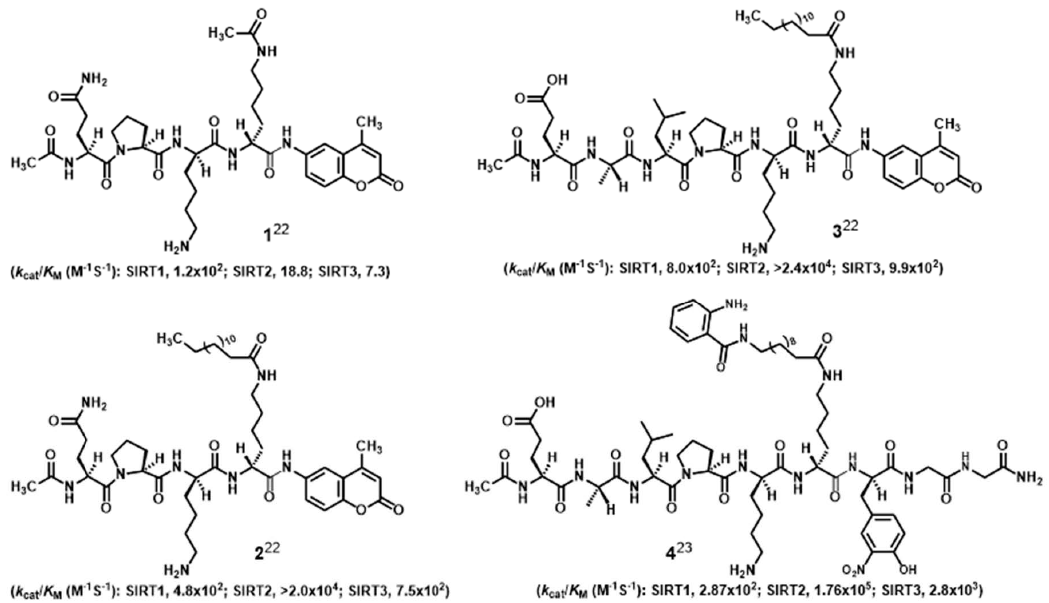
Figure 2. Notable examples of the currently existing in vitro SIRT1/2/3 substrates. Note: (i) the k cat / K M values for the SIRT1/2/3-catalyzed deacylation of these substrates are shown in the parenthesis below each chemical structure. (ii) The sequence of peptides 1 and 2 was derived from tumor suppressor protein p53, and that of peptides 3 and 4 was derived from the tumor necrosis factor α (TNF α ).